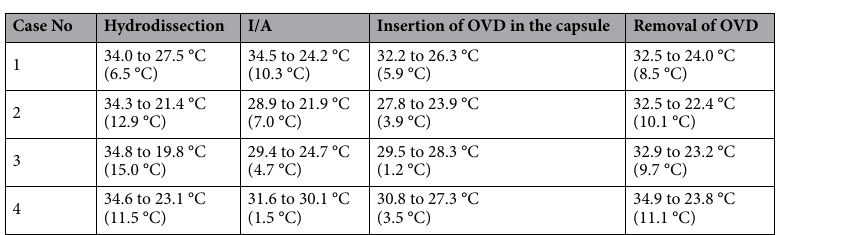
Table 1. Reduction in the intraocular temperature during four surgical procedures performed at a room temperature of 20 °C and eye-holder temperature setting of 36 °C. Data are presented as maximum to minimum (difference). I/A, irrigation and aspiration; OVD, ophthalmic viscosurgical